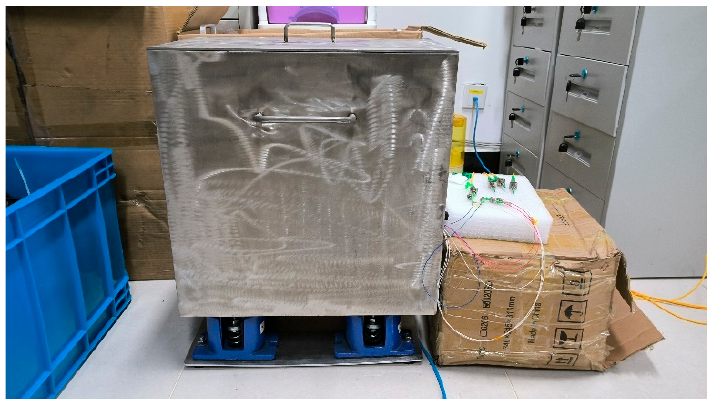
Figure 12. Vibration isolation box is used for phase resolution test.